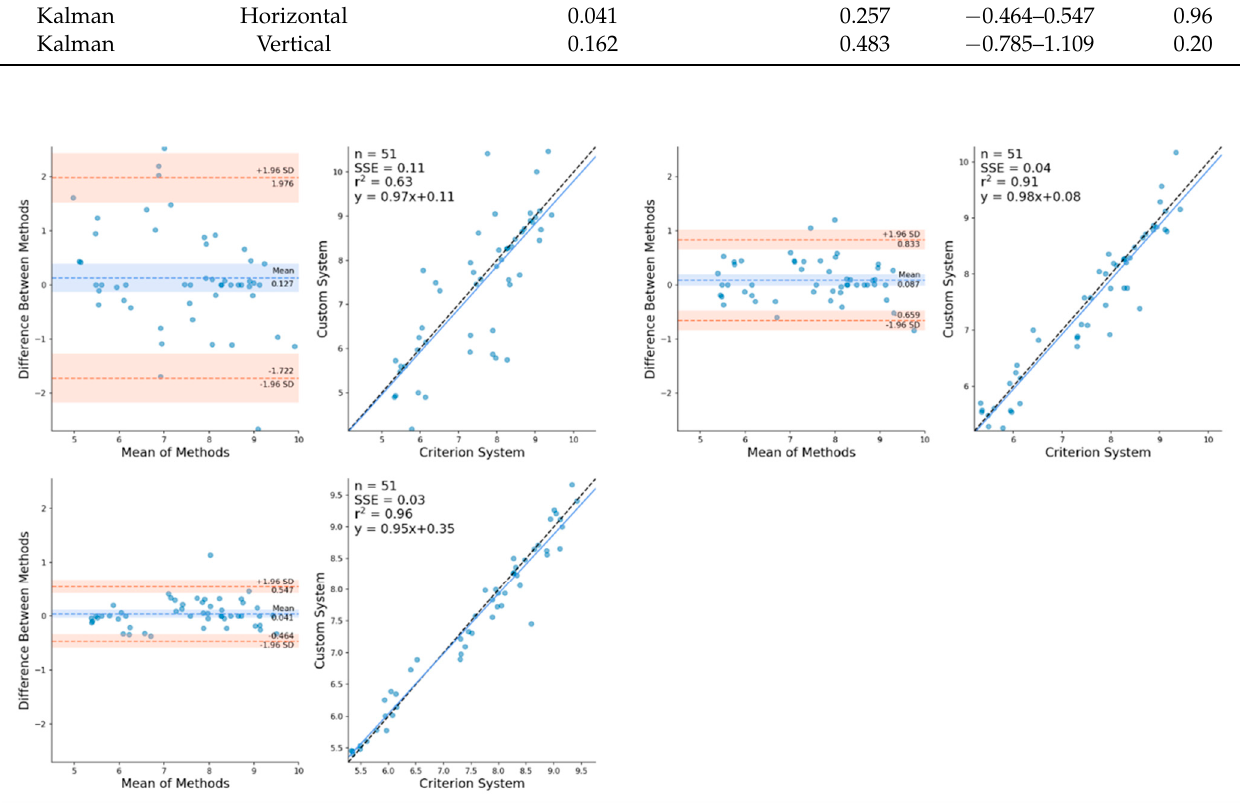
Figure 3. Bland–Altman and linear regression plots demonstrating the mean differences between OpenPose unfiltered ( top-left ), low-pass filtered ( top-right ) and Kalman smoothed ( lower-left ) CoM horizontal velocity against marker-based CoM horizontal velocity during sprinting.